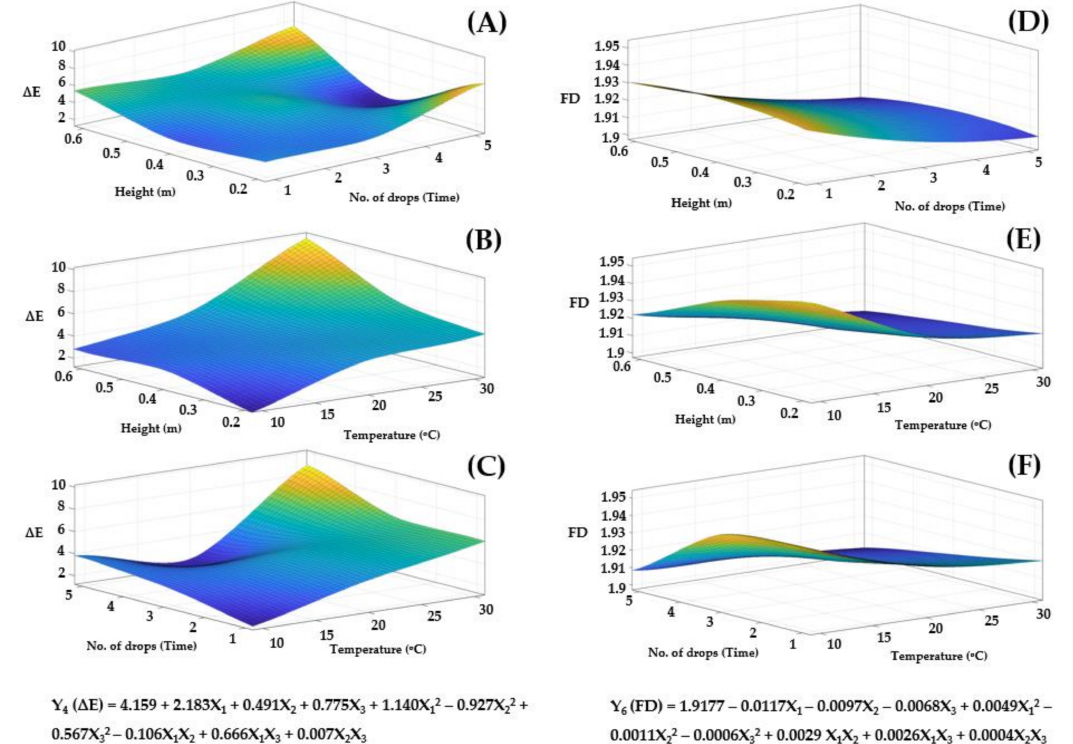
Figure 5. Response surface plot graphs of ∆ E and FD variables were created from Equations (10) and (12), respectively. Response surface plots demonstrating effects of drop height, number of drops, and storage temperature on total color difference ( ∆ E) and fractal dimension (FD) ( D – F ) in ‘Glom Sali’ guava impact bruising at various drop heights and number of drops ( A , D ), different drop heights and temperature ( B , E ), and different number of drops and storage temperature ( C , F